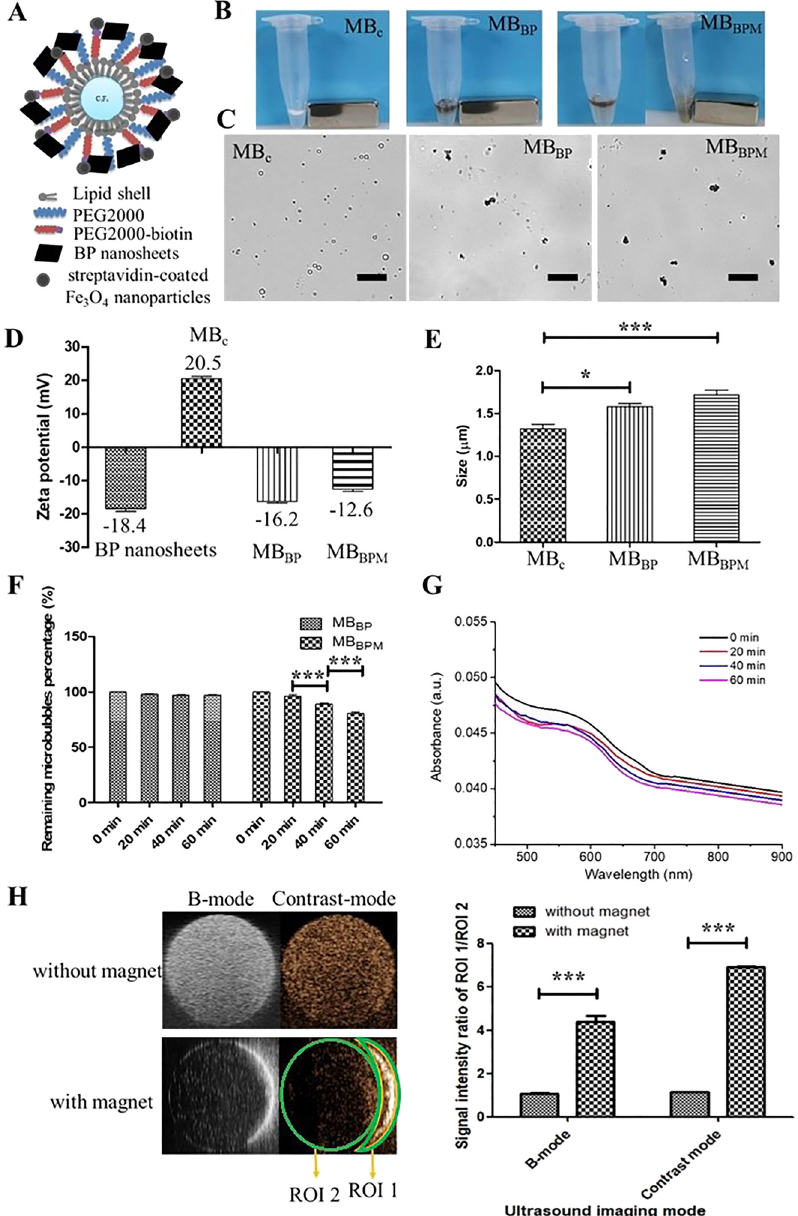
). The BPM has a c